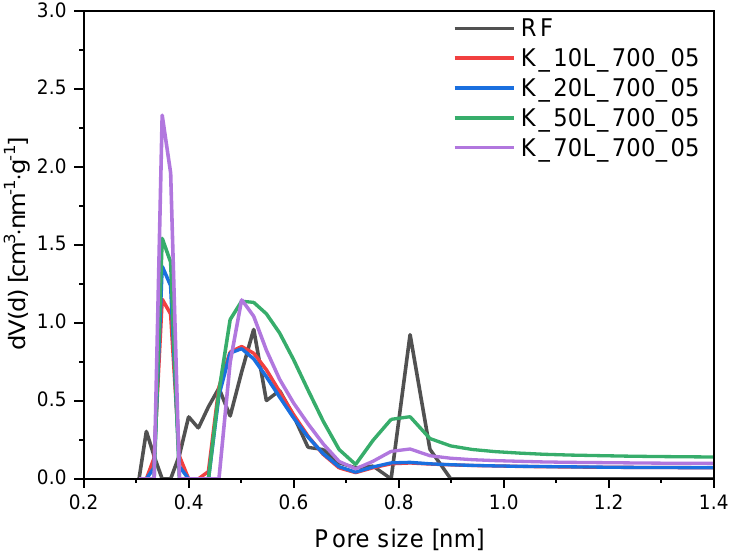
Figure 6. PSD of the samples activated with different content of KOH using a solid-based method.